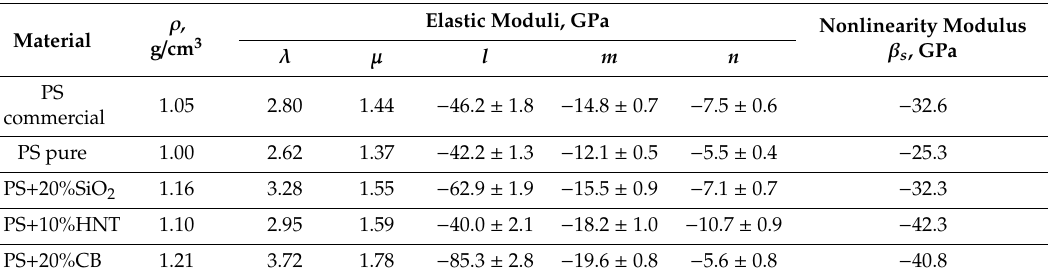
Table 4. Second- and third-order elastic moduli of nanocomposite samples determined from ultrasonic measurements. Second-order moduli λ and µ are measured within error tolerance of 0.02 and 0.01 GPa,